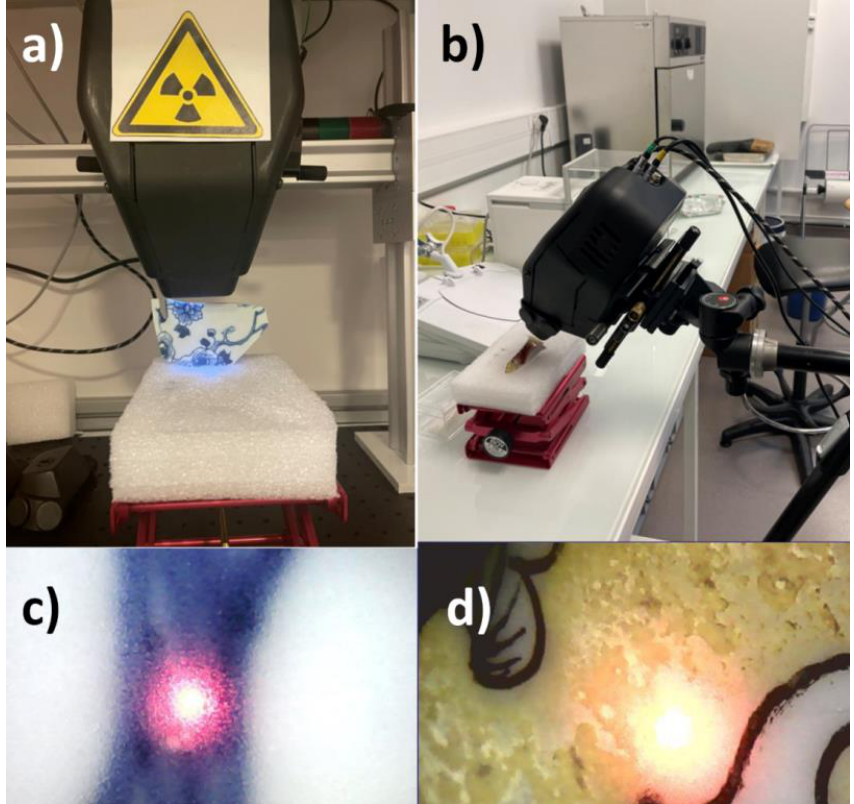
Figure 2. The two measurement configurations: ( a ) vertical instrument fixed to a movable support placed on a bench; ( b ) use of a tripod; ( c , d ) example of focus showing a ‘good’ focus on a flat perpendicular area (support on a bench) and a ‘less good focus’, elongated, on a convex surface close to another colored area. Note the heterogeneity of the yellow area. Center halo diameter ~ ×1.2 mm.